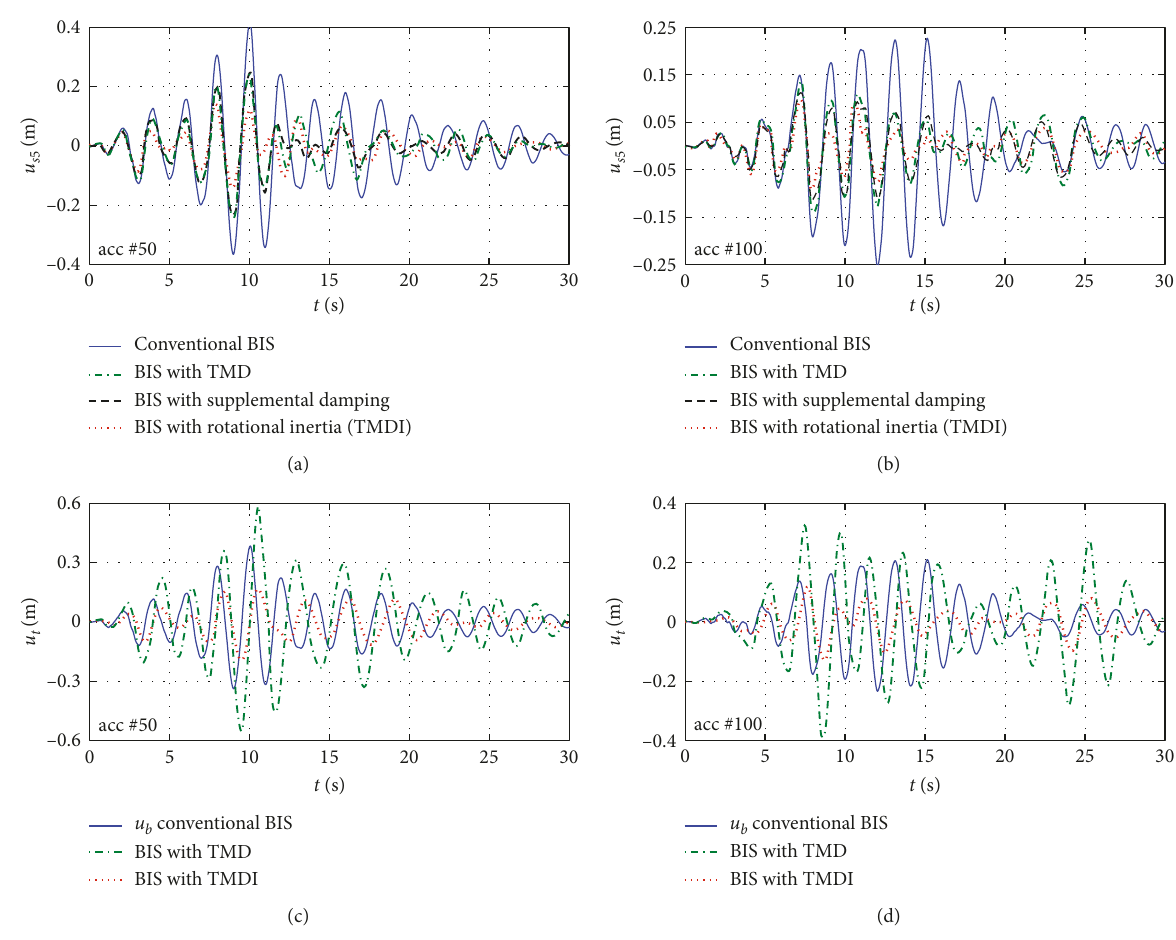
Figure 15: Time-history response of the RC building shown in Figure 14 subject to two arbitrary artificial accelerograms: (a, b) last-floor displacement; (c, d) secondary system (BIS, TMDI, TMD)